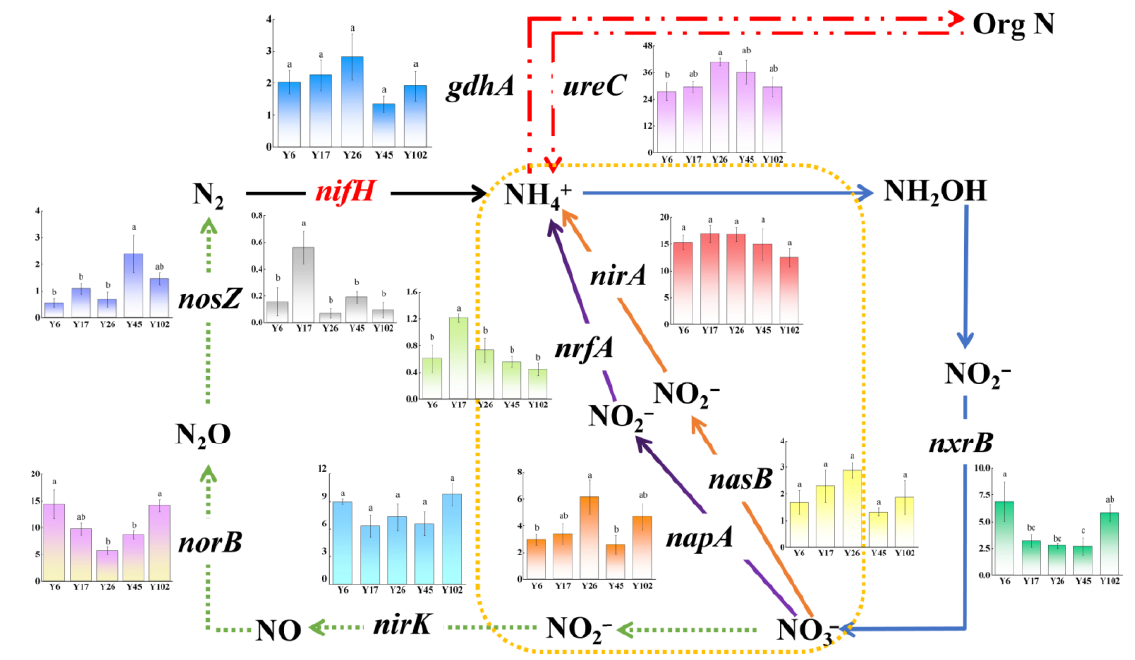
Figure 4. Nitrogen cycling processes and abundance of corresponding functional genes (10 − 6 ) of rhizosphere microbial communities in Chinese fir stand ages in subtropical China. The different letters indicates significant differences at p < 0.05.